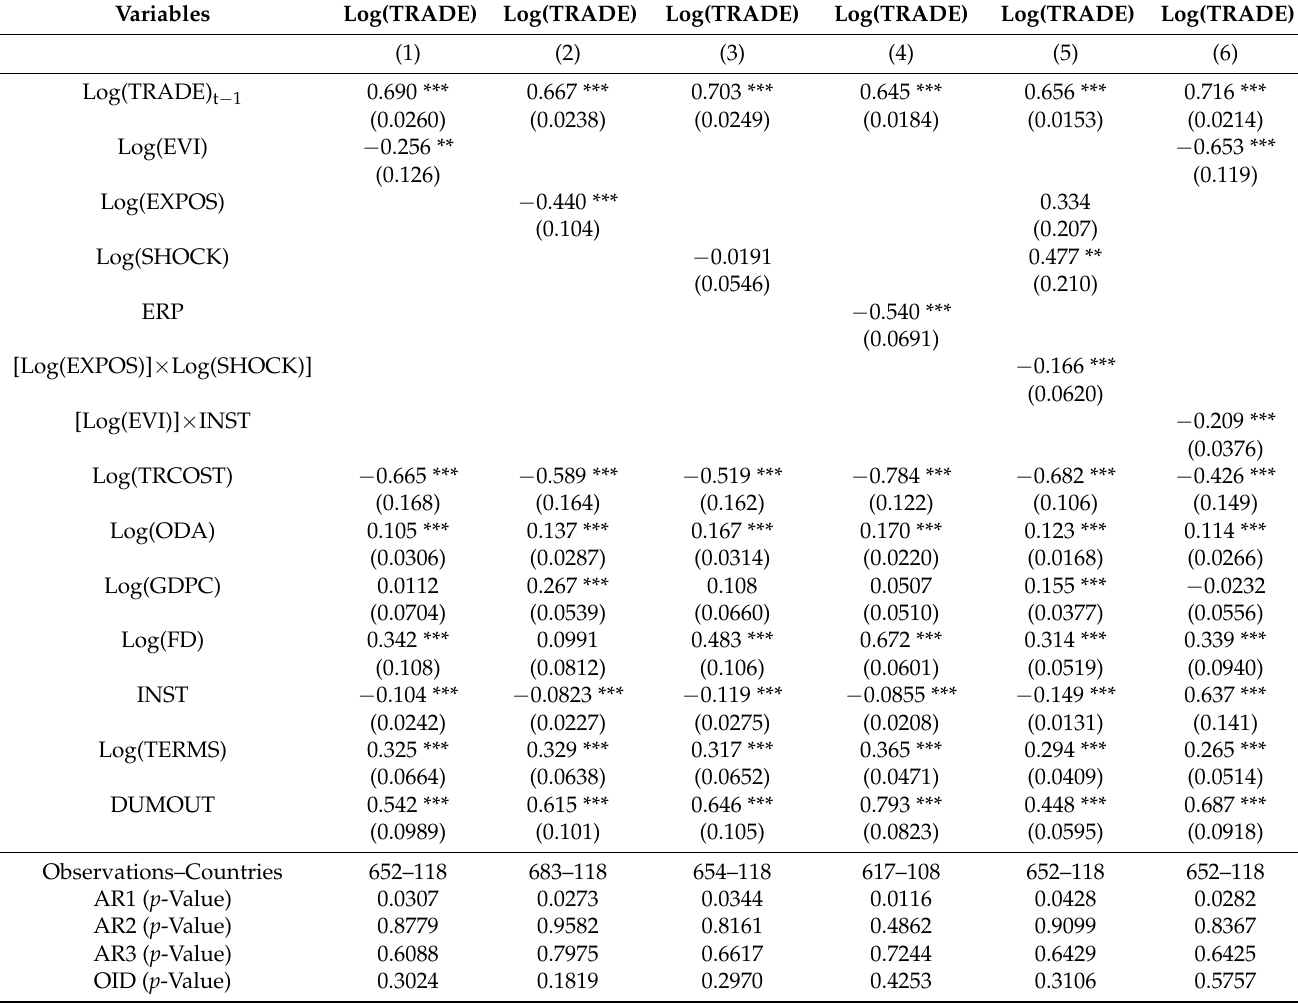
Table 1. Effect of EVI on participation in international trade. Estimator : Two-step system